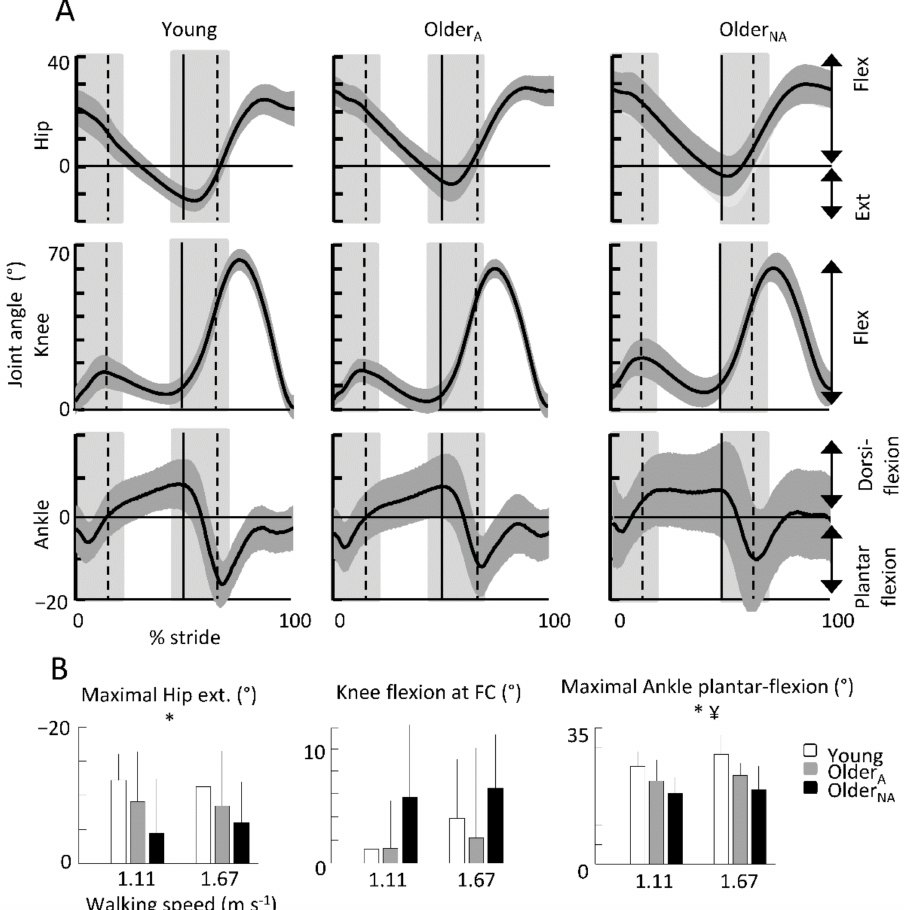
Figure 2. Joint kinematics. ( A ) Ensemble-average traces of the hip, knee and ankle angle joint taken from the right side of the subjects during a stride for the three groups walking at 1.11 m · s − 1 . All the curves of each subject were first averaged (mean curve). The curves presented here are the average of the mean curves of all the subjects (ensemble-average) and the dark grey areas are the standard deviations. Positive values correspond to flexion (dorsiflexion for the ankle) and negative values correspond to extension (plantar-flexion for the ankle). ( B ) Maximal hip extension (left), knee flexion at foot contact (middle) and maximal ankle plantar-flexion (right). The symbols * and ¥ indicate a significant effect of age and speed, respectively. Other indications as in Figure